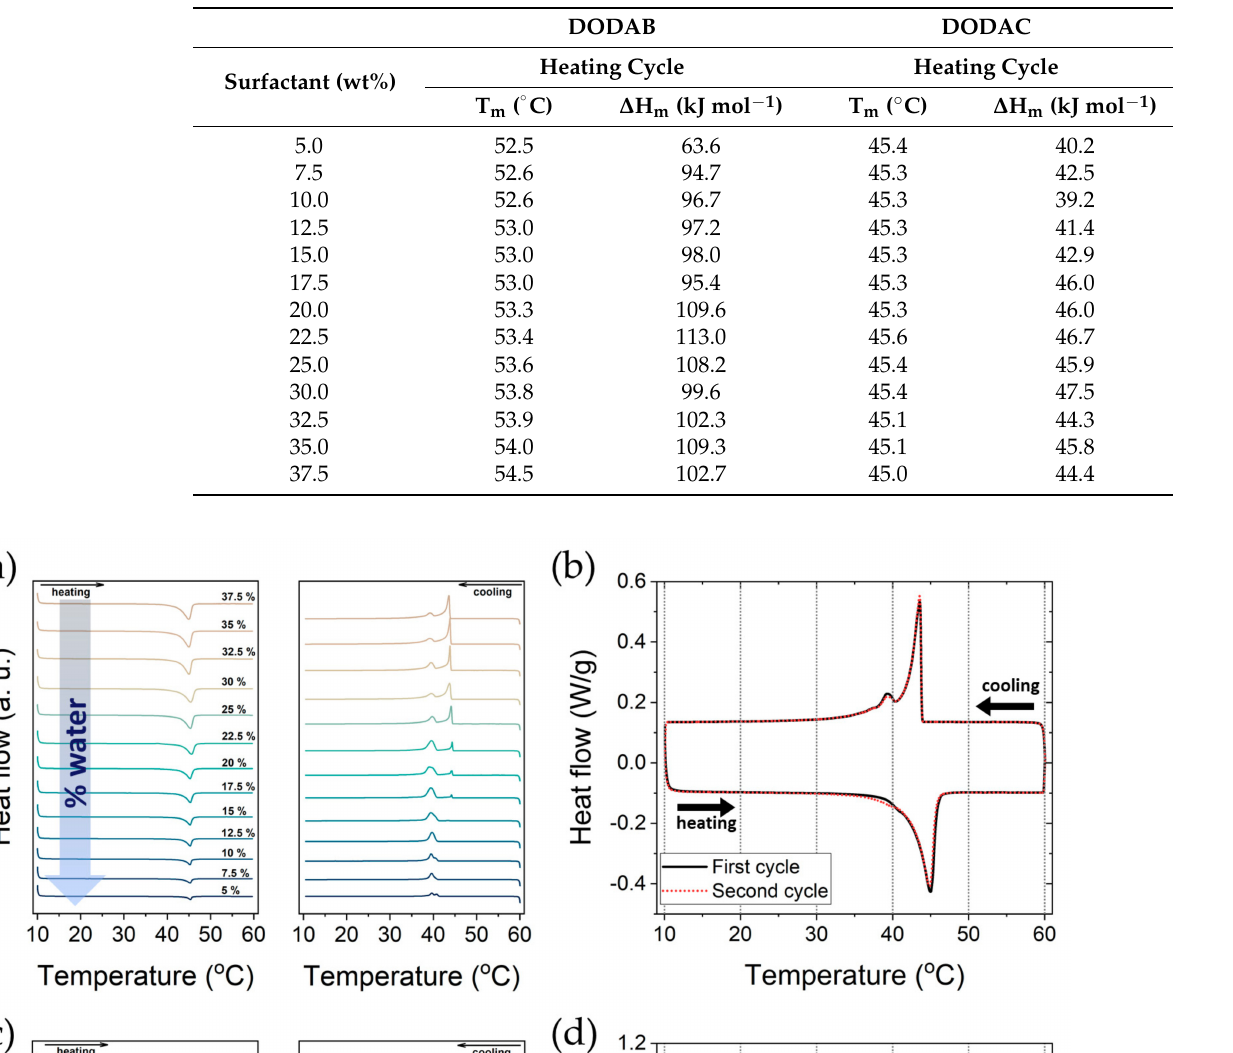
Table 1. Normalised differential scanning calorimetry parameters of the DODAB and DODAC in water from 5 to 37.5 wt% of surfactant.